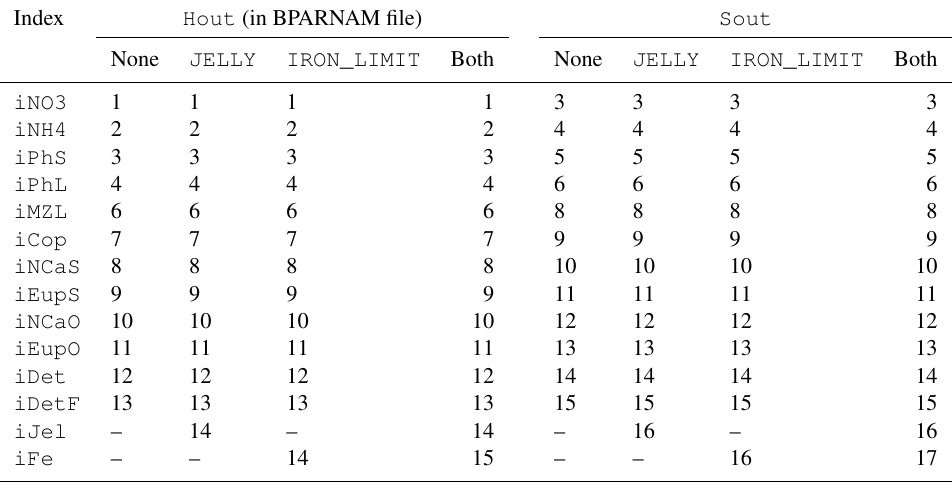
Table C2. Indices in the idTvar array. Note that Hout(idTvar) appears separately in the ocean.in file and BPARNAM file, with the latter including only biological active tracers. The Sout(idTvar) input appears only once, in the STANAME file, and biological tracer indices begin at NAT + 1; NAT is here assumed to be 2, for temperature and salinity. In all cases, note the skip between iPhL and iMZL due to the now-deprecated small microzooplankton